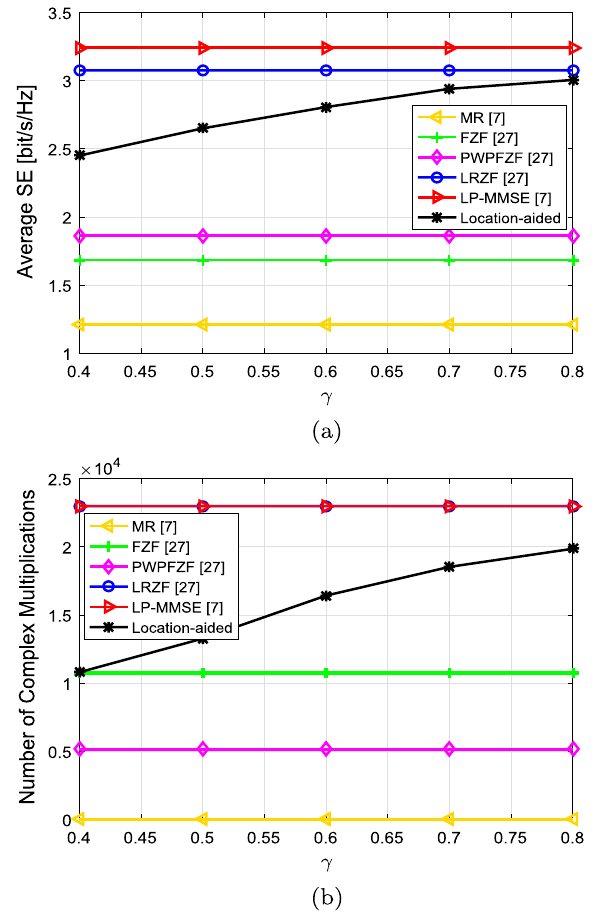
Fig. 5 Average SE and the number of complex multiplications versus the threshold γ for different combining schemes, where M = 8, N = 30, K = 40 and τ p =